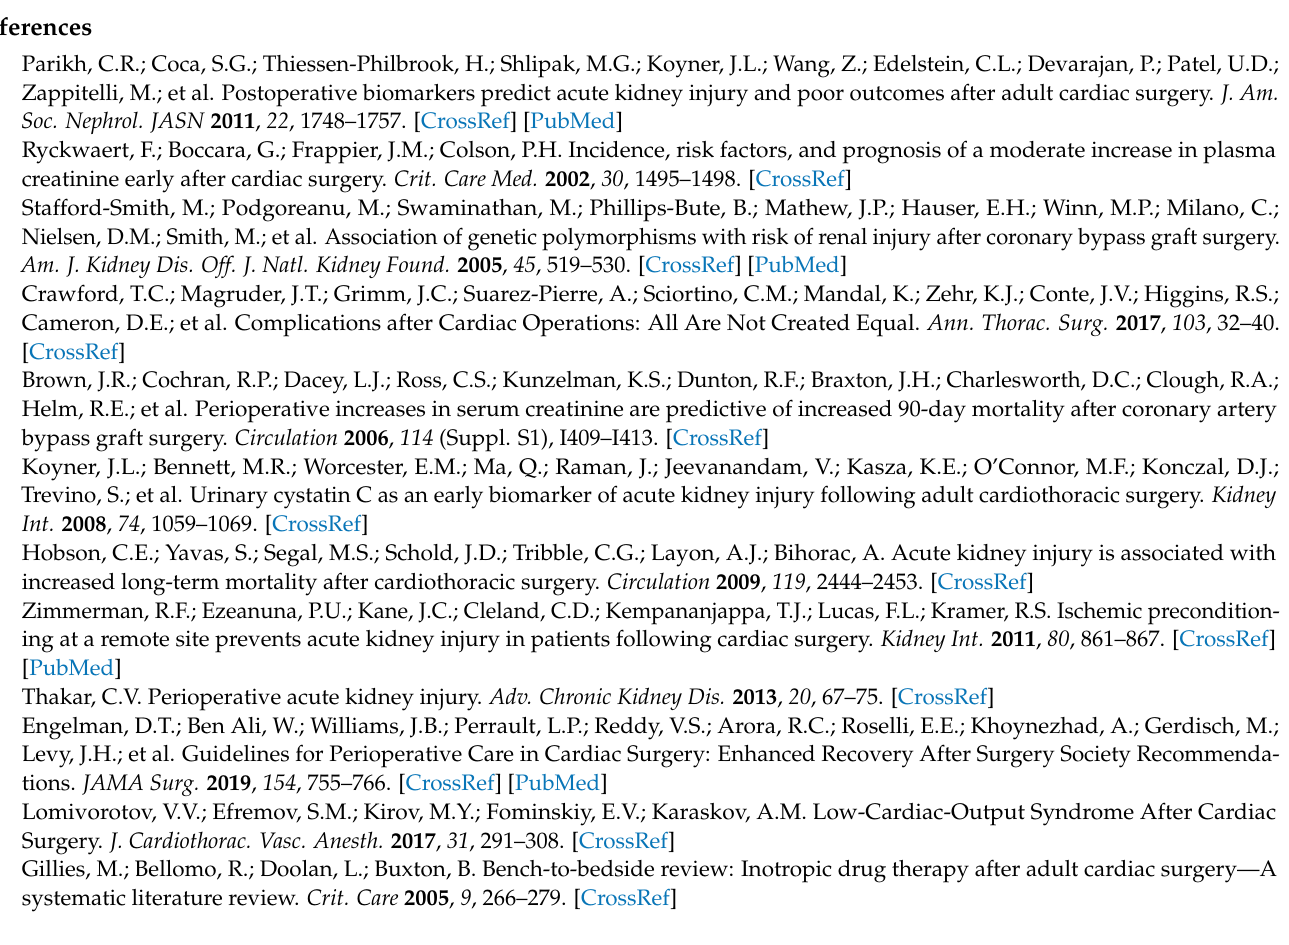
Figure S1: Network plot for included therapies, Figure S2: Risk of bias, Figure S3: Funnel plot for each outcome, Figure S4: Subgroup analyses for mortality by administration timing, Figure S5: Subgroup analyses for mortality by operation method, Figure S6: Subgroup analyses for AKI by systolic function, Figure S7: Subgroup analyses for AKI by administration timing, Figure S8: Subgroup analyses for AKI by operation